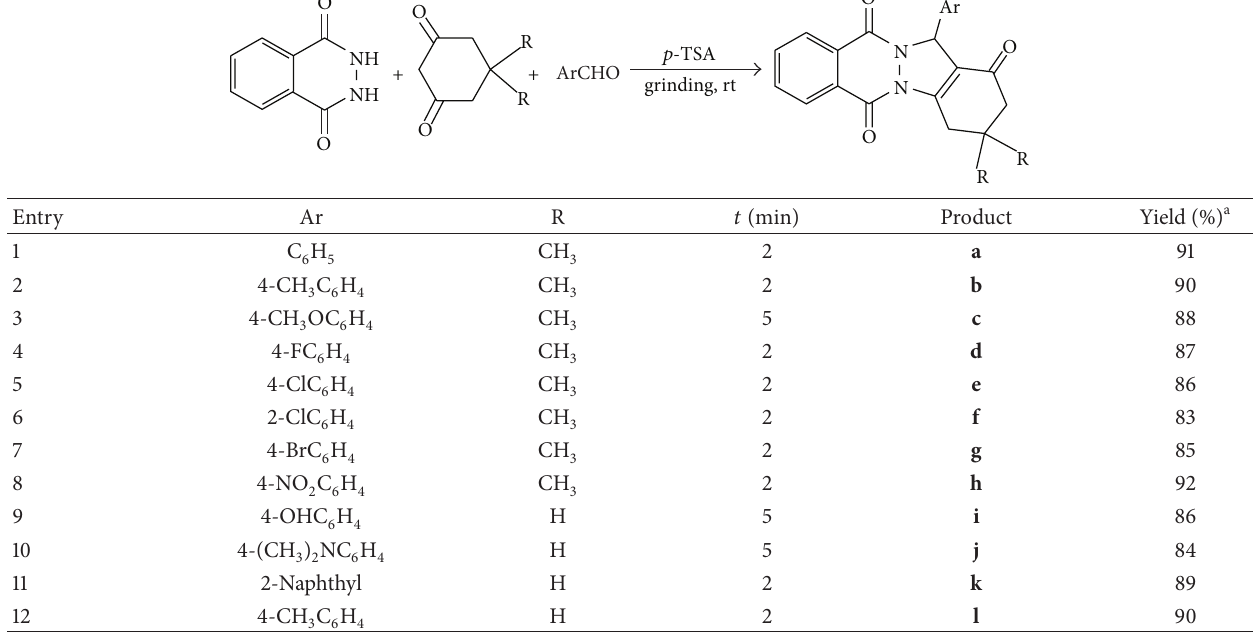
Table 2: Synthesis of 2 H -indazolo[2,1- b ]phthalazine-trione derivatives under grinding.